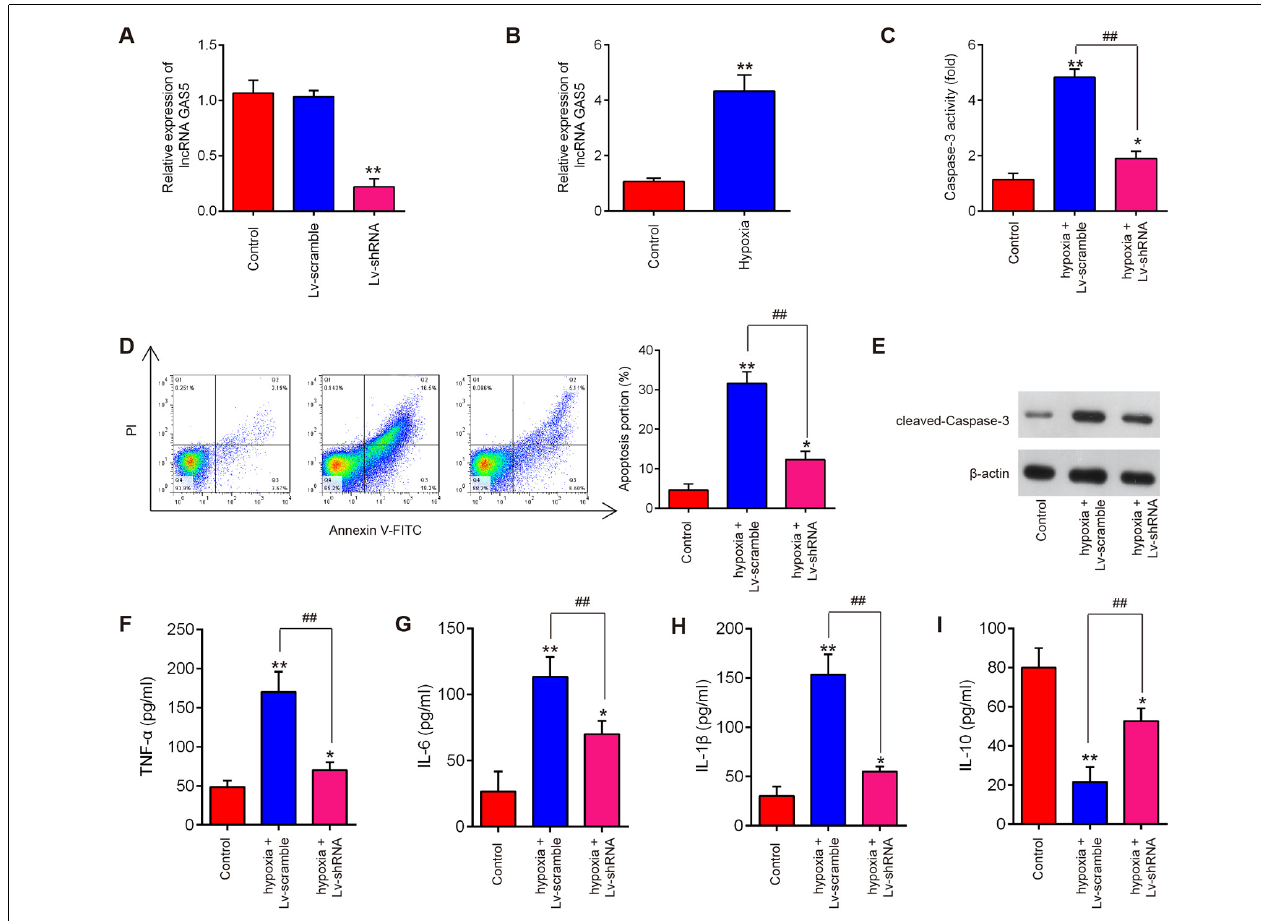
FIGURE 3 | Silencing of long noncoding RNA (lncRNA) GAS5 reducing apoptosis and inflammation in HT22 cells under hypoxic conditions. (A) Transfected efficiency of lentivirus short-hairpin RNA (LV-shRNA) in HT22 cells as detected by quantitative reverse transcription polymerase chain reaction (qRT-PCR) analysis. (B) Expression levels of lncRNA GAS5 in HT22 cells under hypoxic conditions as measured by qRT-PCR. (C) The activity of caspase-3 measured using a caspase-3 activity assay kit. (D) Percentage of apoptotic neuronal cells detected using flow cytometry. (E) Protein expressions of cleaved caspase-3 as measured by Western blotting. (F–I) Levels of tumor necrosis factor (TNF)- α , interleukin (IL)-6, IL-1 β , and IL-10 in cells as measured using enzyme-linked immunosorbent assay. Data represent the mean ± SD of three independent experiments. * p < 0.05, ** p < 0.01 vs. control group; ## P < 0.01 vs. hypoxia + LV-scramble